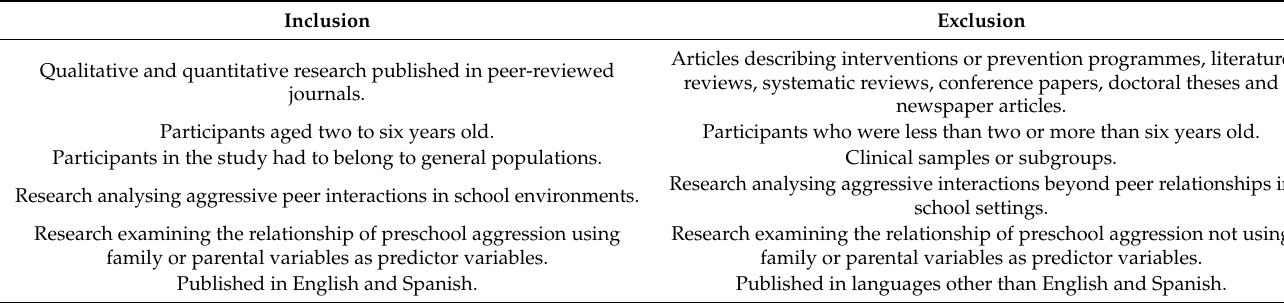
Figure 1. Selection procedure flow chart. Table 2. Summary of the inclusion and exclusion